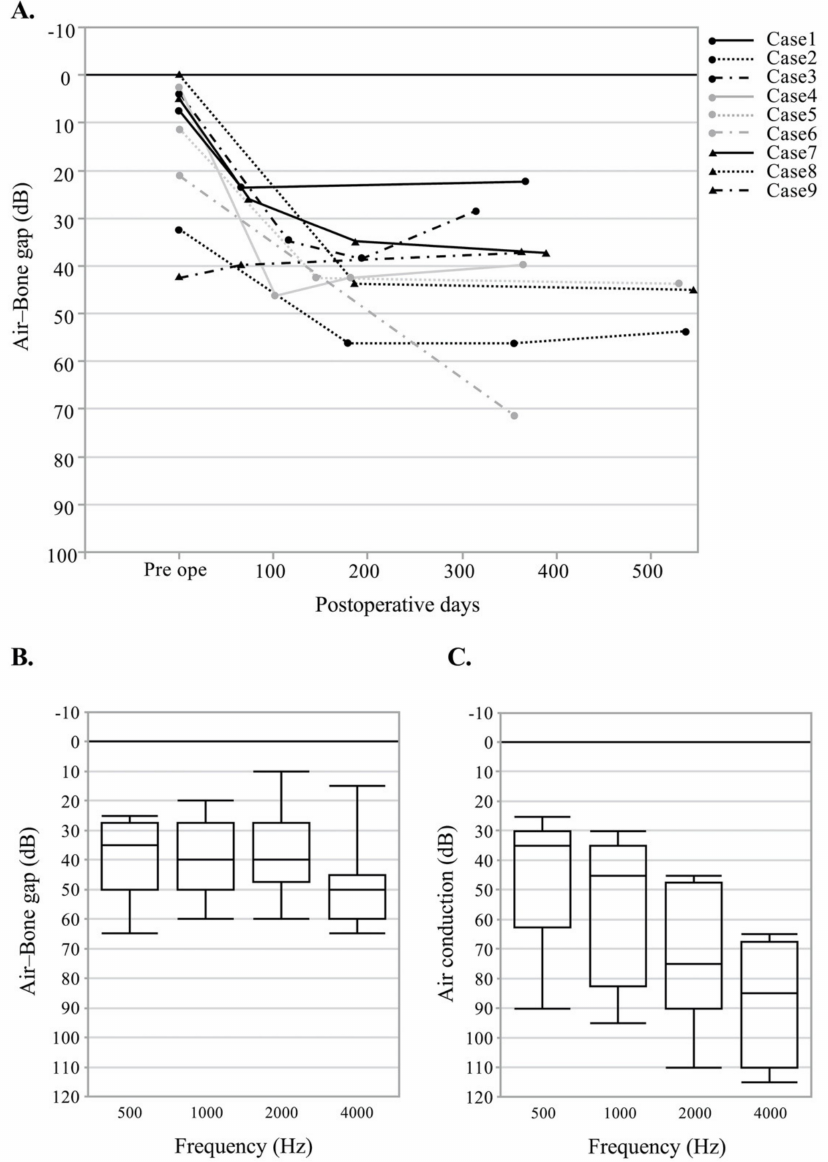
Figure 2. Postoperative hearing level of nine cases with reconstruction of the auditory canal with a free flap. ( A ) Hearing outcome of air–bone gap after surgery in nine patients. ( B ) Air–bone gap by frequency after surgery. ( C ) Air conduction level by frequency after surgery. The horizontal line within the box represents the median sample value. Box boundaries represent the 1st and 3rd quartiles. Whiskers extend from quartiles to the minimum/maximum data